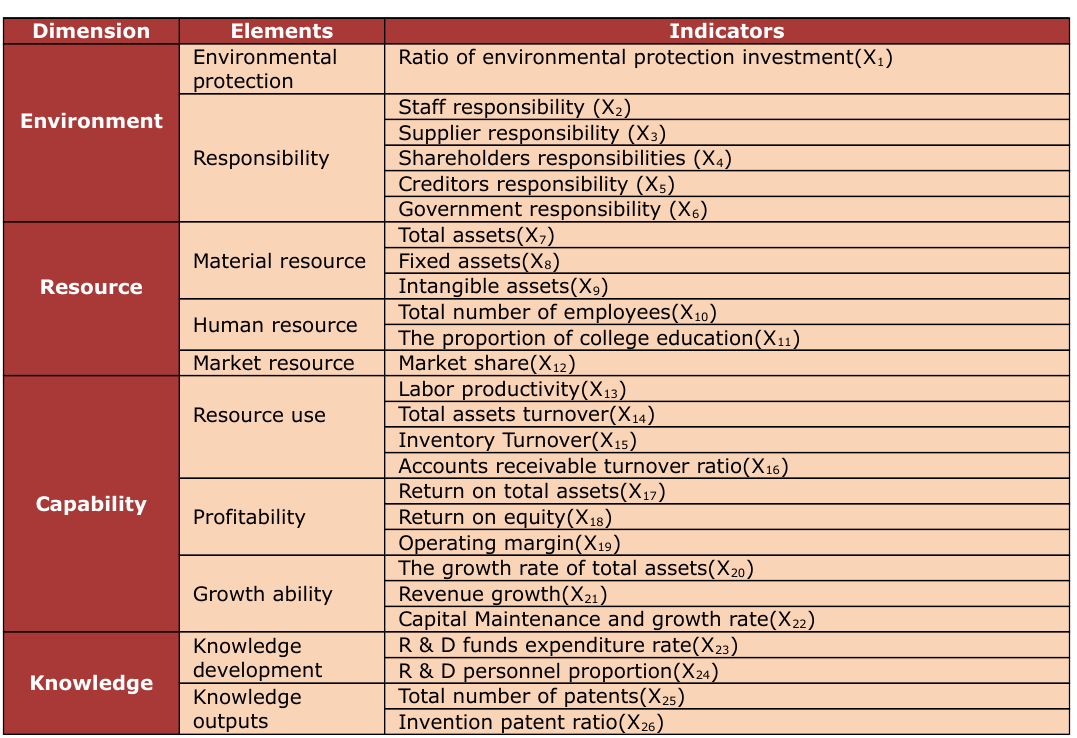
4 ． Empirical analysis of green competitiveness for automotive